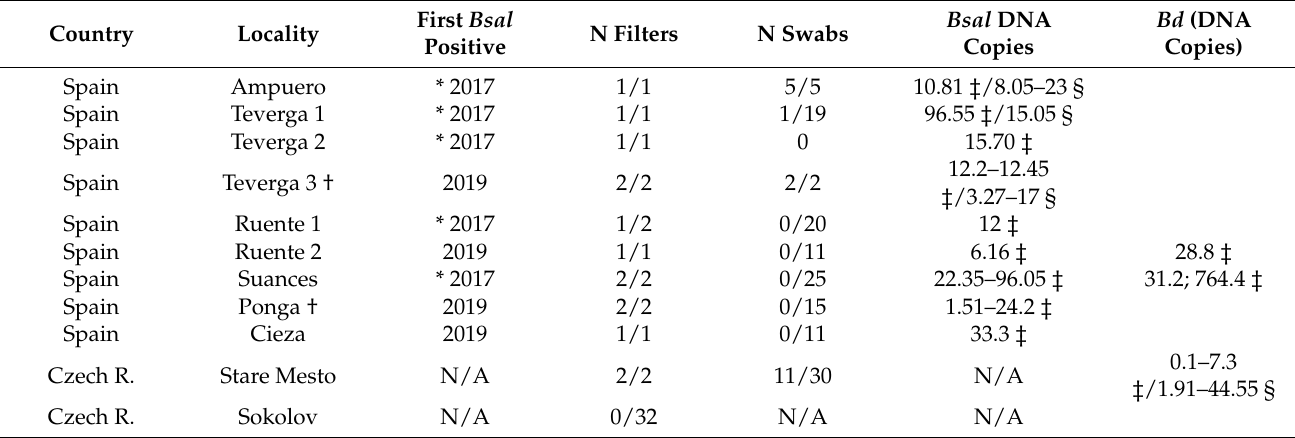
Table 1. List of Batrachochytrium salamandrivorans ( Bsal ) and B.dendrobatidis ( Bd ) positive localities in 2019. Number (N), (number of positive samples/number of collected samples). Distances between particular water bodies within the Teverga and Ruente localities are at least 5